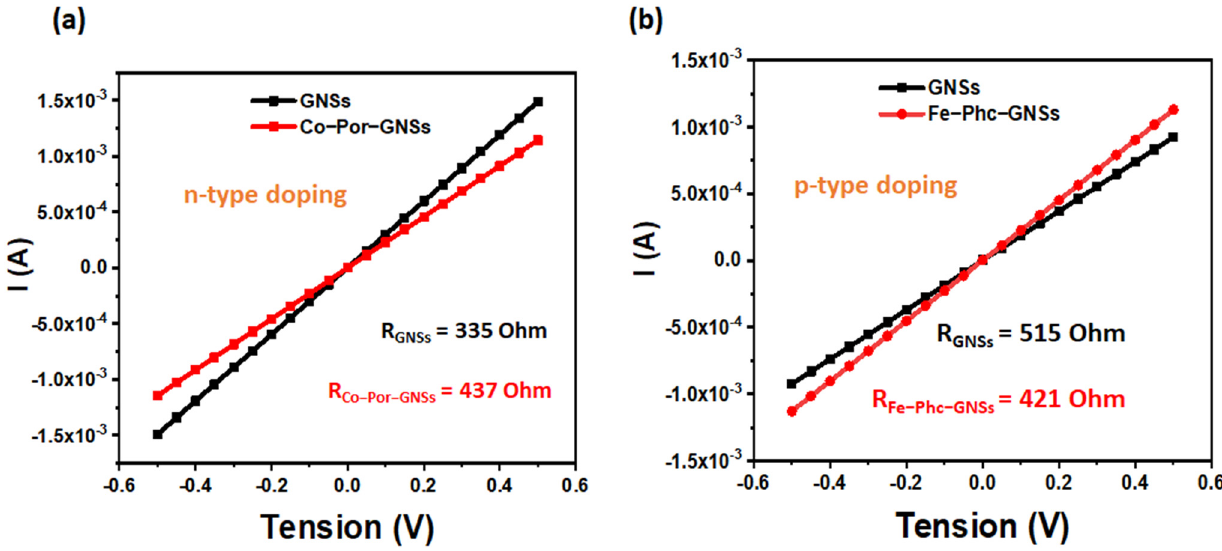
Figure 7. I versus V curves of GNSs and functionalized GNSs with Co − Por and Fe − Phc: ( a ) GNSs and Co − Por − GNSs; ( b ) GNSs and Fe − Phc − GNSs.